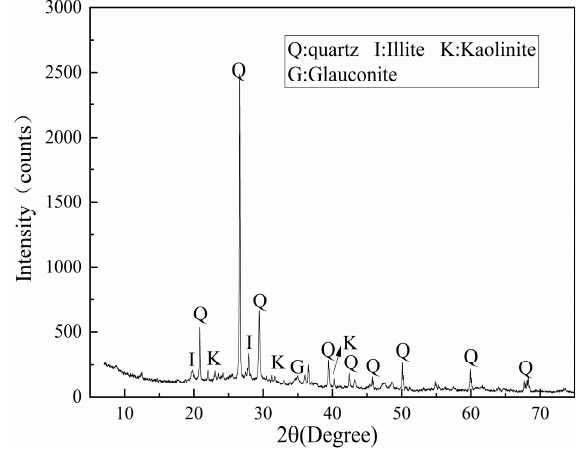
Figure 1. The XRD pattern of sludge.